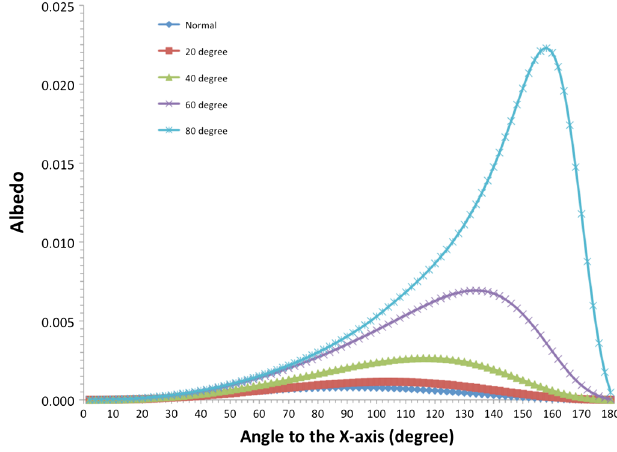
FIG. 6. Integrated probability density for the out-of-plane scat- tering angle for various incident beam angles. Zero degrees represents the incident